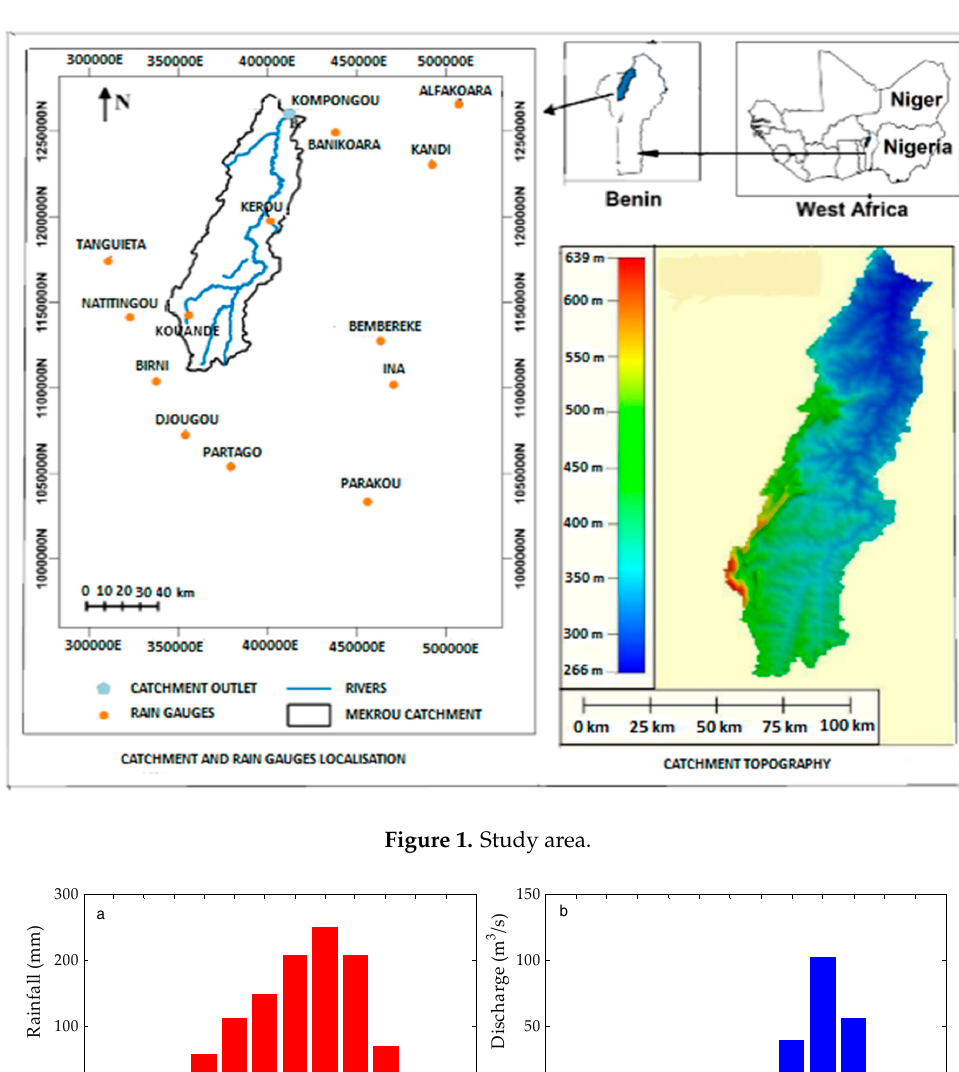
Figure 2. Seasonal variability of rainfall and discharge in the basin (( a ) Monthly rainfall amounts over 1981–2014; ( b ) Monthly mean of discharge over 2006–2012).